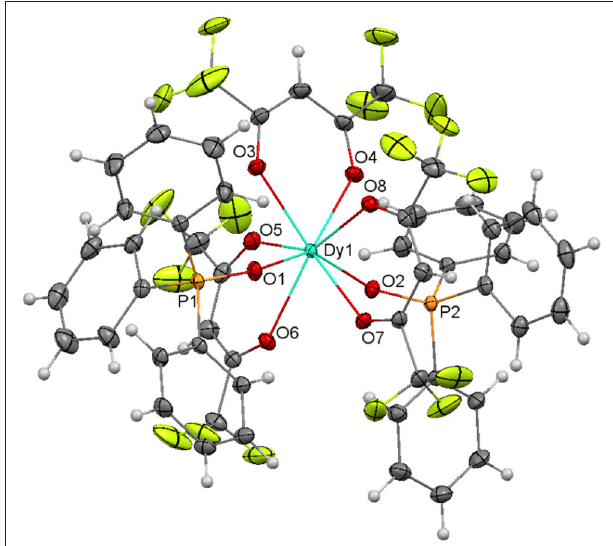
FIGURE 8 | Ellipsoids diagram (50% probability) for 8. Only the Dy, P, and donor O-atoms have been labeled, for clarity. Color code: Dy, light blue; C, gray; F, fluorescent yellow; H, light gray; O, red; P,